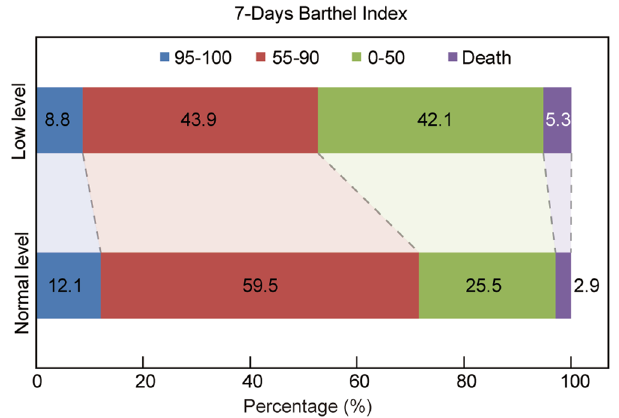
Figure 1. The raw distribution of scores on the Barthel Index at 7 days in the group with low level of albumin (less than 35 mmol/L) and the group with normal level of albumin (35–55 mmol/L). Categorizing patients into 4 groups according to Barthel Index: score 95–100 indicating no symptoms, 55–99 slight-to-moderate disability, 0–50 severe disability. In this picture, fewer people scored 55–100 were found in low level of serum albumin, but there is no statistically significant difference between two groups ( P =